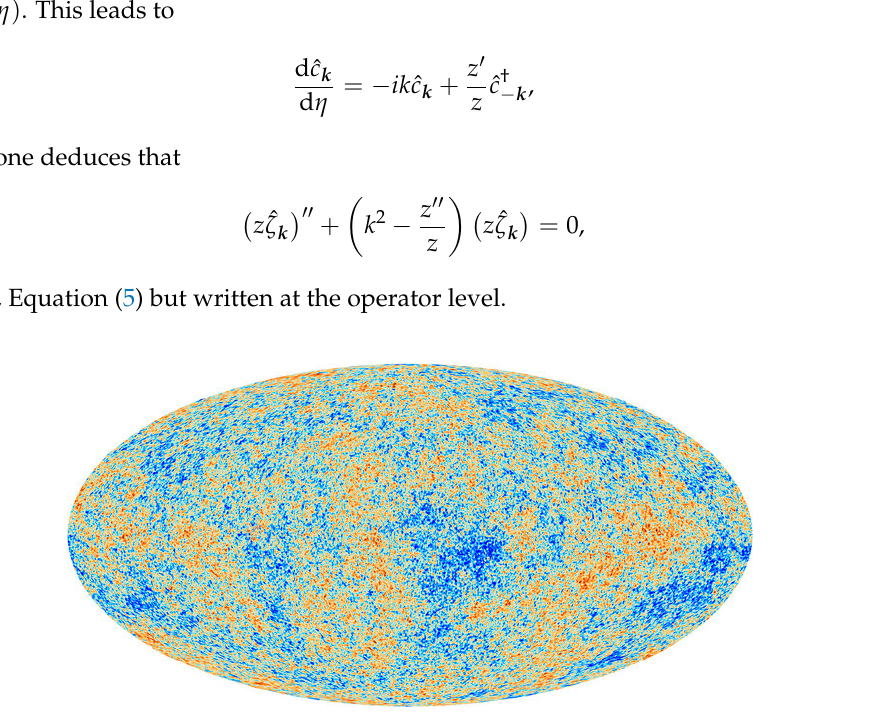
Figure 1. Map of the CMB anisotropies obtained by the European Space Agency (ESA) Planck satellite [17–21]. It represents the most exquisite measurement of the CMB ever